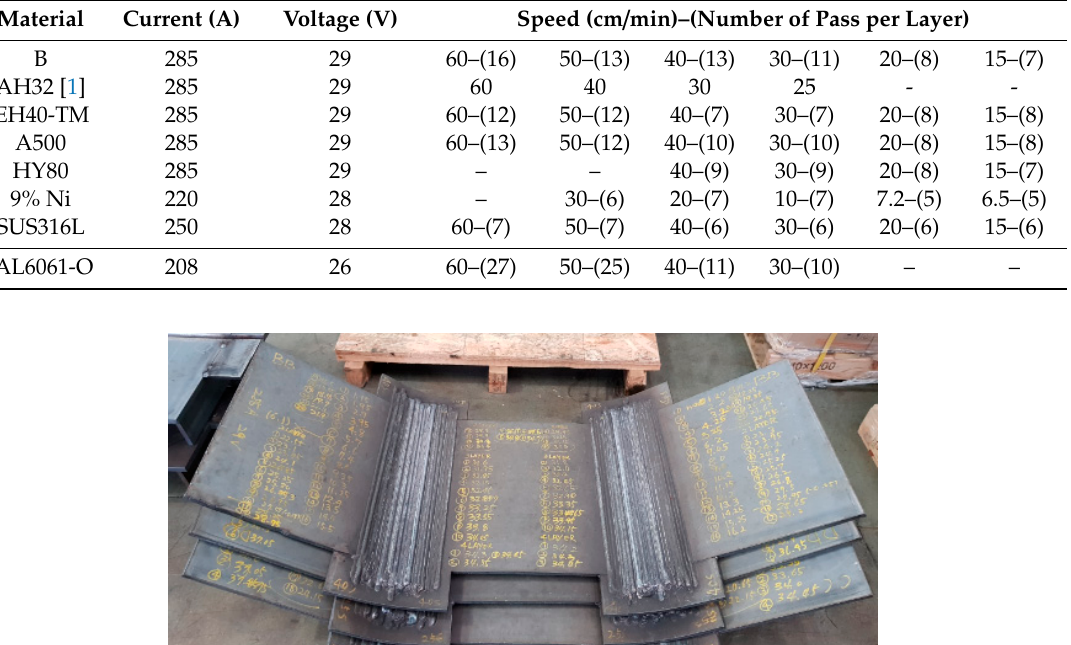
Table 3. Heat input conditions for BOP experiments.